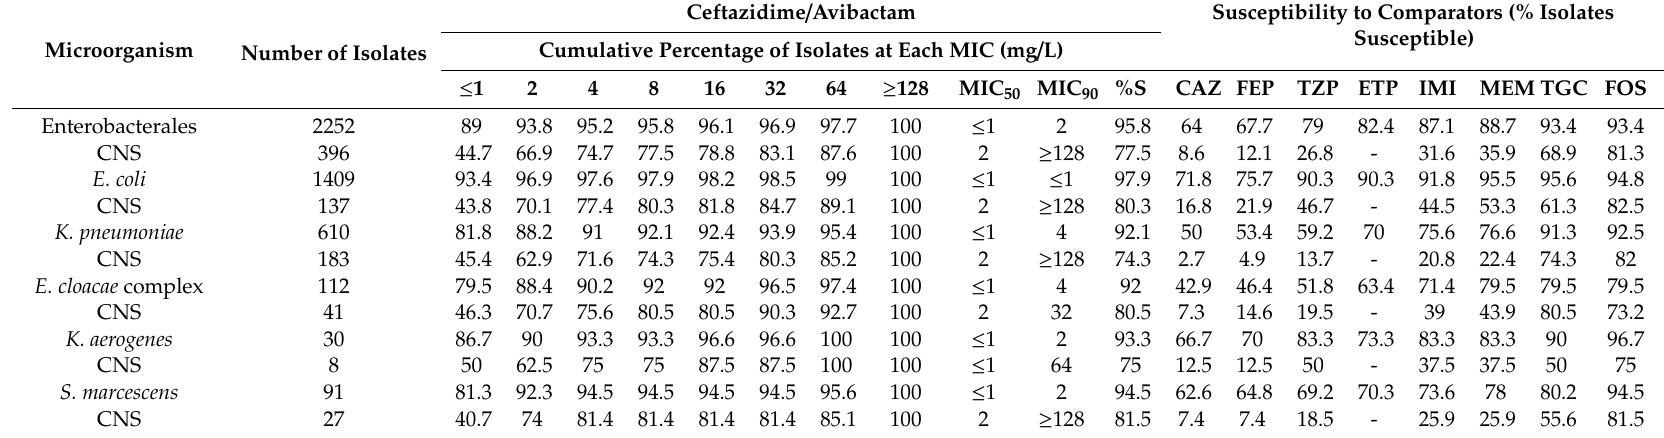
Table 2. Susceptibility of Enterobacterales to ceftazidime / avibactam according to minimum inhibitory concentration (MIC) (mg / L) distribution and susceptibility to